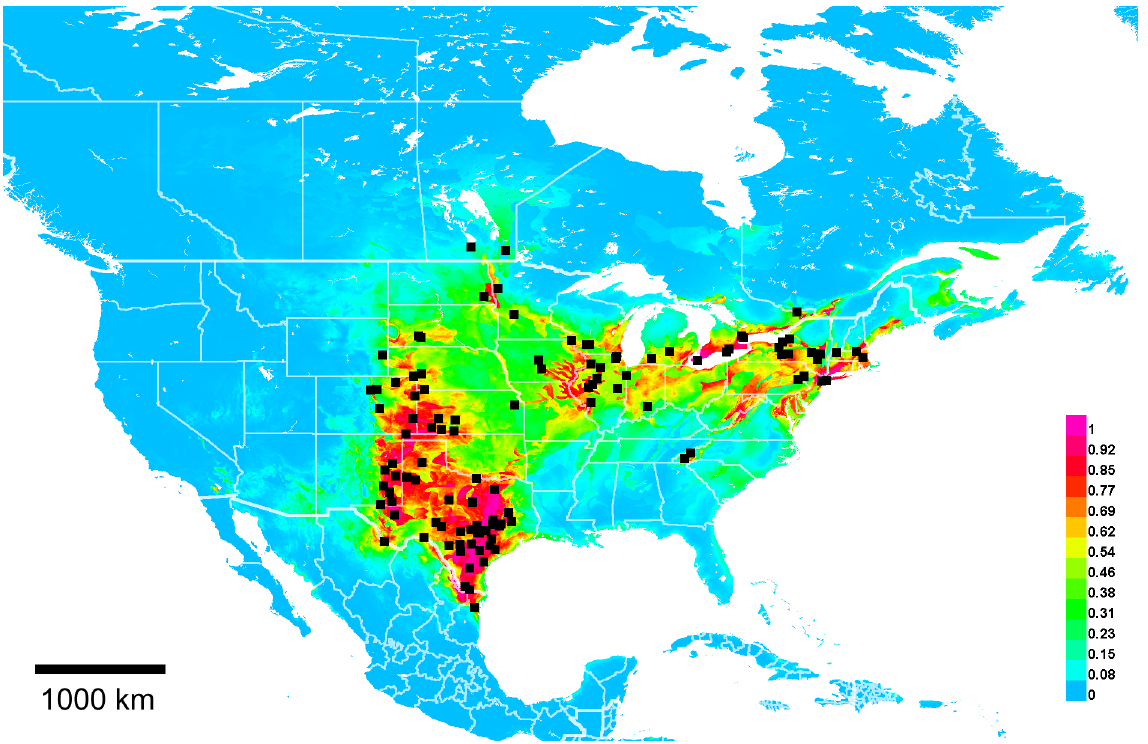
Fig. 20. Georeferenced collection records of Lasioglossum ( D .) ellisiae (Sandhouse, 1924) (black squares) and predicted distribution by maximum entropy ecological niche modelling in Maxent (colour shading). Warmer colours indicate higher cloglog probability of